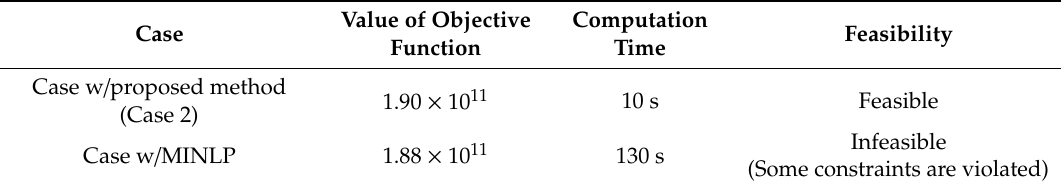
Table 6. Comparison of results obtained using the proposed method and the mixed integer non-linear programming (MINLP)